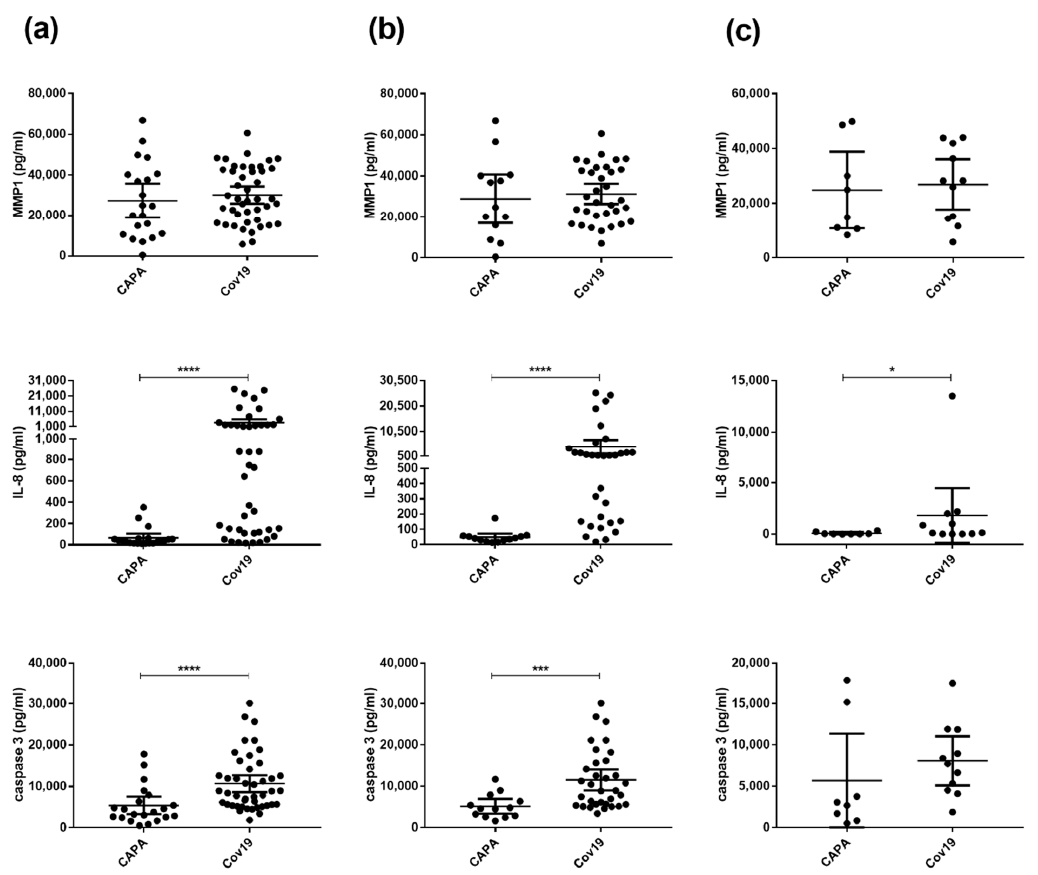
Figure 6. Protein quantification of MMP1, IL-8, and caspase-3 candidates in an independent patient cohort (Cardiff II) consisting of CAPA patients (CAPA) and control COVID-19 patients (Cov19) without Aspergillus infection (Cov19; N = 45). MMP1, IL-8, and caspase-3 serum protein levels are shown as mean values with 95% confidence intervals and were measured in ( a ) all investigated COVID-19 patients (N = 65), ( b ) in male COVID-19 patients (N = 46), and ( c ) in female COVID-19 patients (N = 19). The Mann–Whitney test was used to investigate significant differences among investigated CAPA and COVID-19 patients (* p < 0.05, *** p < 0.001, **** p < 0.0001). N, number of patients.